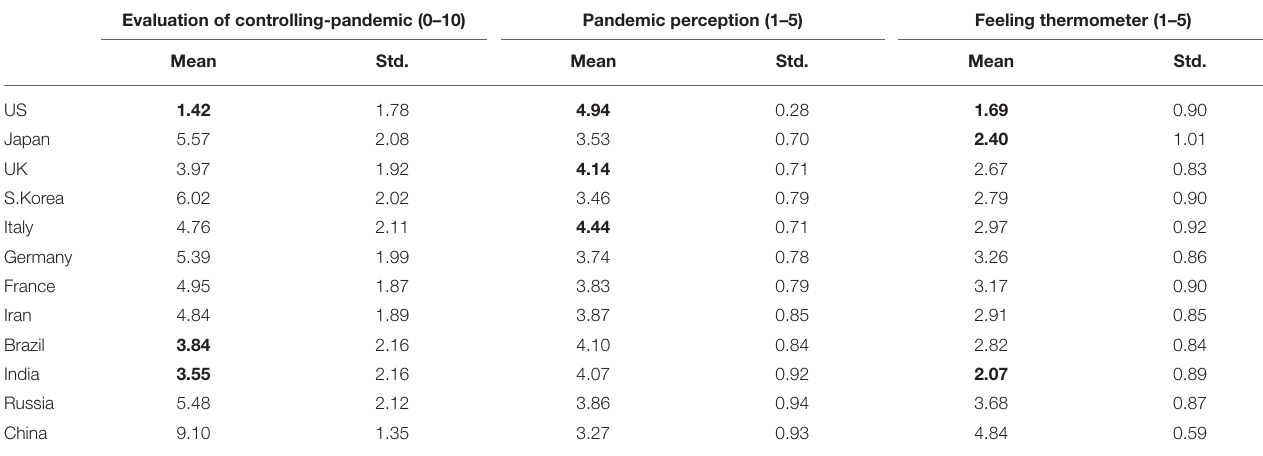
TABLE 2 | Evaluation of controlling-pandemic, pandemic perception, and feeling thermometer of the Chinese public in different countries ( N = 619). Evaluation of controlling-pandemic